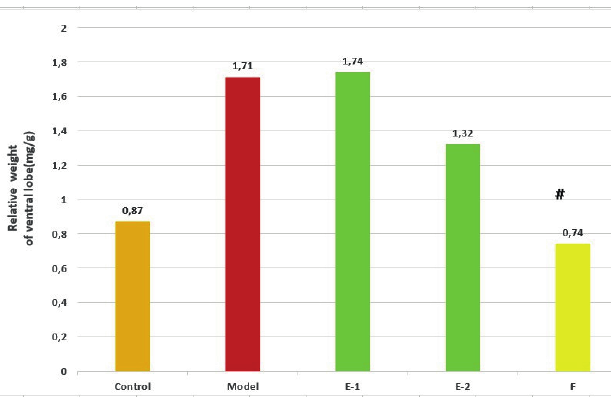
FIGURE 1 - Relative weight of the ventral lobe. Model: BPH, E-1: Extract-30 mg/kg, E-2: Extract-60 mg/kg, F: Finasteride- 10mg/kg. The data were stated as mean ± SE. Superscript sign shows significant difference: #–from Model, #p < 0.05.